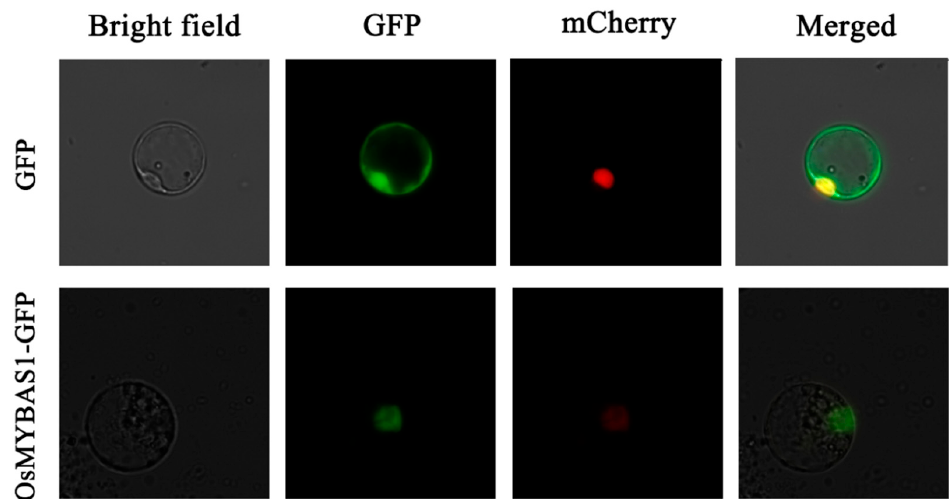
Figure 2. Subcellular localization analysis of OsMYBAS1 . Confocal images of rice protoplasts cells under the GFP channel showing the constitutive localization of GFP and the nuclear localization of OsMYBAS1 ‐ GFP. Confocal images of rice protoplasts cells under the mCherry channel showing the constitutive localization of mCherry. The merged images of GFP and OsMYBAS1 ‐ GFP are presented, respectively.